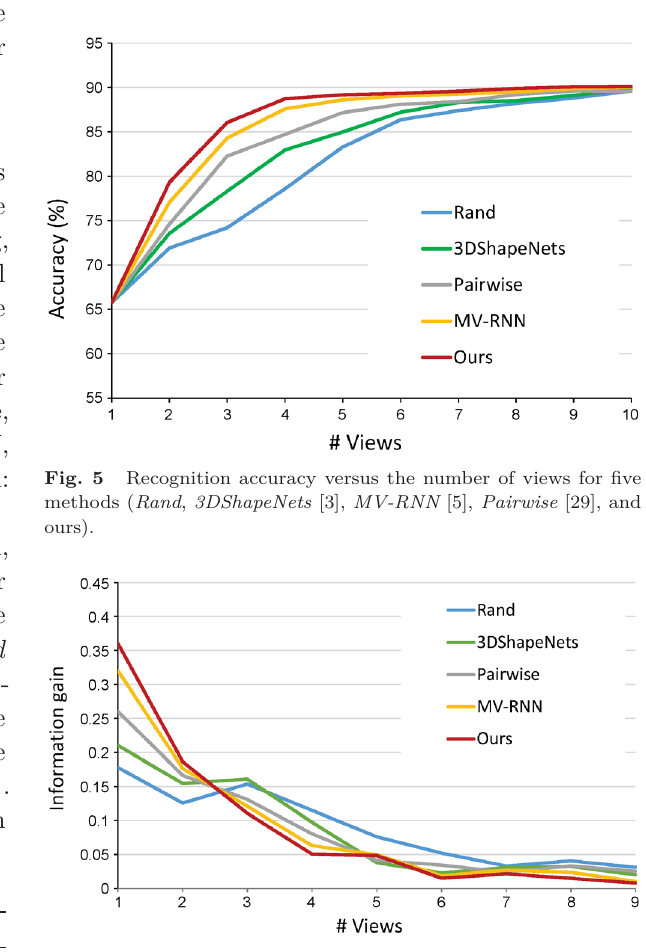
Fig. 6 Information gain for views selected by five methods ( Rand , 3DShapeNets [3], MV-RNN [5], Pairwise [29], and